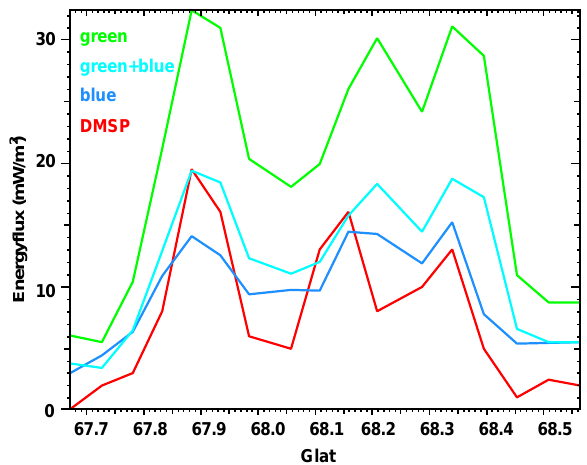
Fig. 4. Inverted energy flux of the triple arc from green (green curve), blue (blue curve) and green plus blue (turquoise curve) ASC images. The corresponding DMSP satellite measurement is given by the red